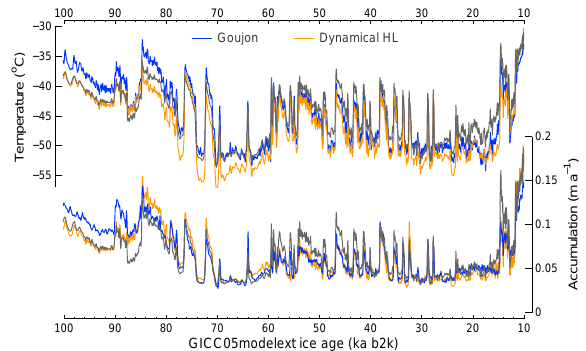
Fig. A1. Temperature ( T , upper) and accumulation ( A , lower) input into the densification models: results from the Goujon (blue) and dynamical Herron–Langway (orange) models are shown together with the grey curves, which show the initial T and A estimates as described in the text.